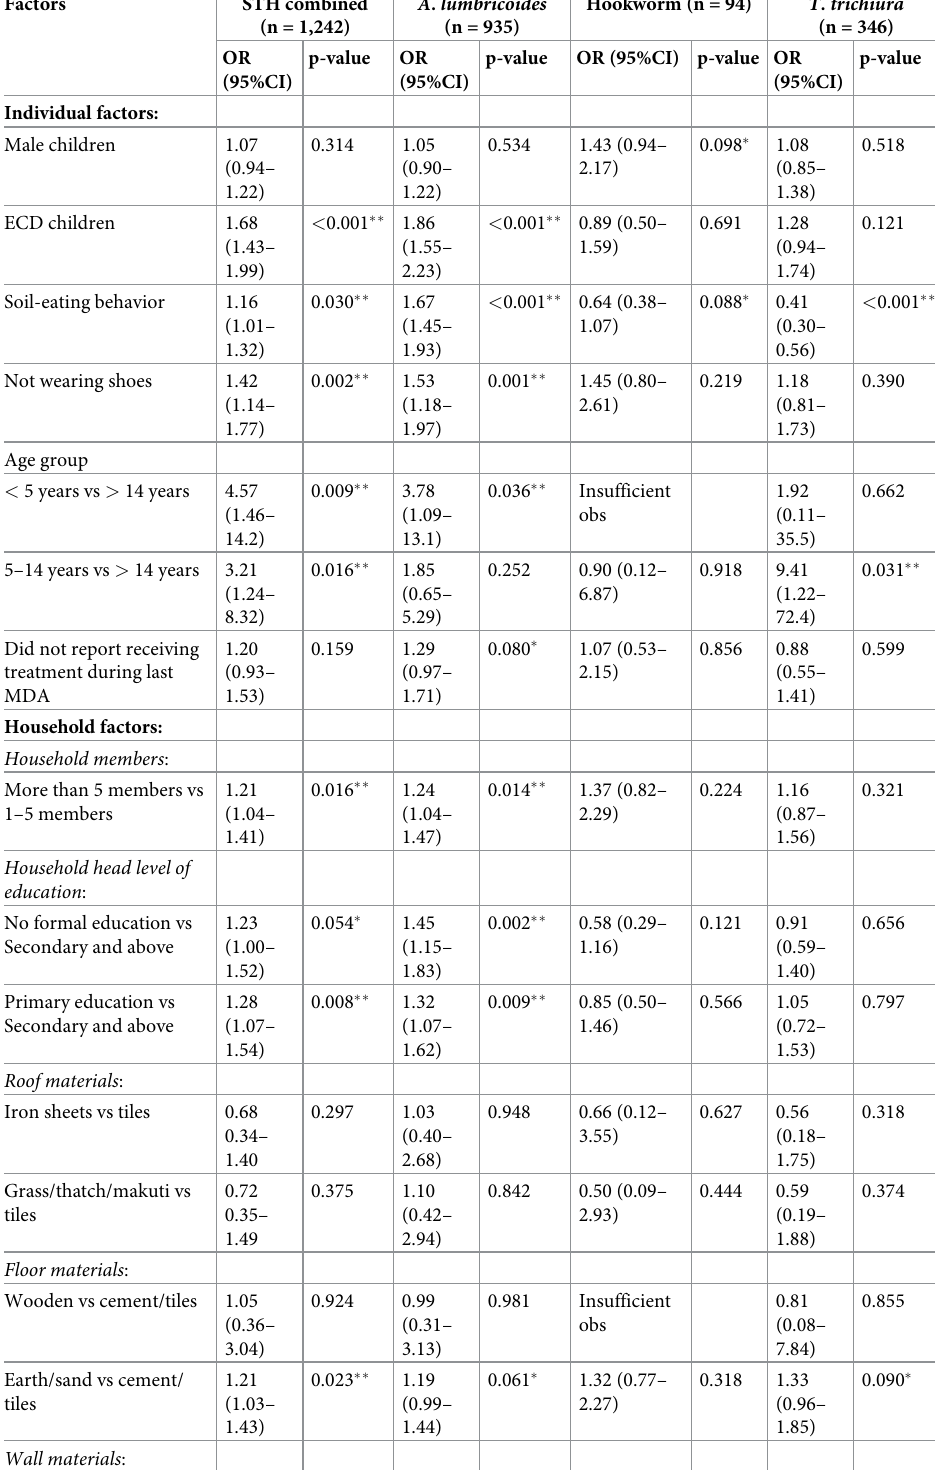
Table 8. Univariable associations between WASH conditions and STH infections among school children in Kenya after five rounds of